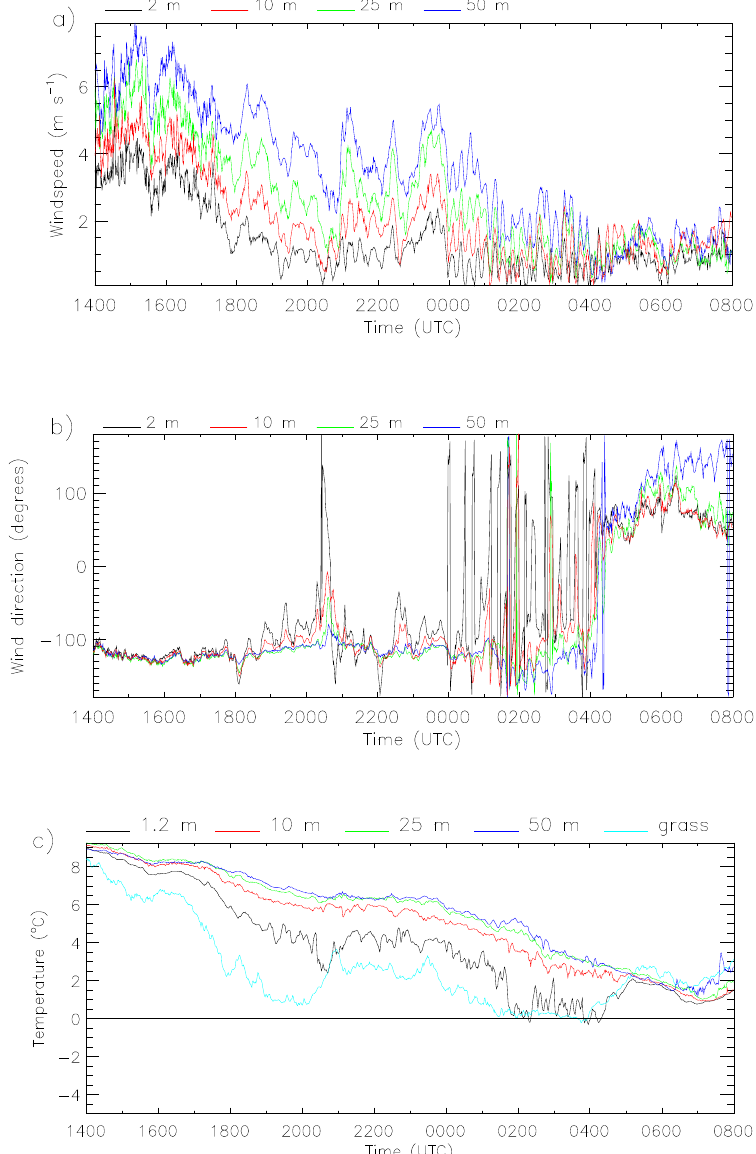
Figure 11. Meteorological data for 11–12 December 2016: ( a ) windspeed, ( b ) wind direction and ( c ) Table 1. min averages.